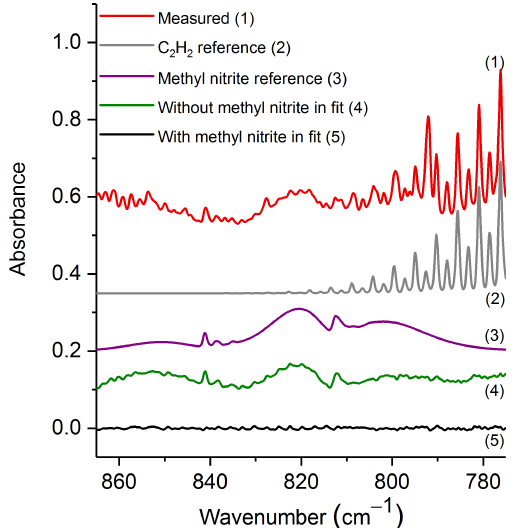
Figure 4. Measured experimental spectrum and the individual spec- tral contributions for the major components (C 2 H 2 and methyl ni- trite) and residuals with and without methyl nitrite included in the fit. For clarity, the spectral contributions for CO 2 , HCN, naph- thalene, C 2 H 4 , allene and H 2 O are not shown. All spectra are at 0.6cm − 1 resolution and have been offset for clarity. The calcu- lated mixing ratio of methyl nitrite in this measured spectrum is 21.0ppm.